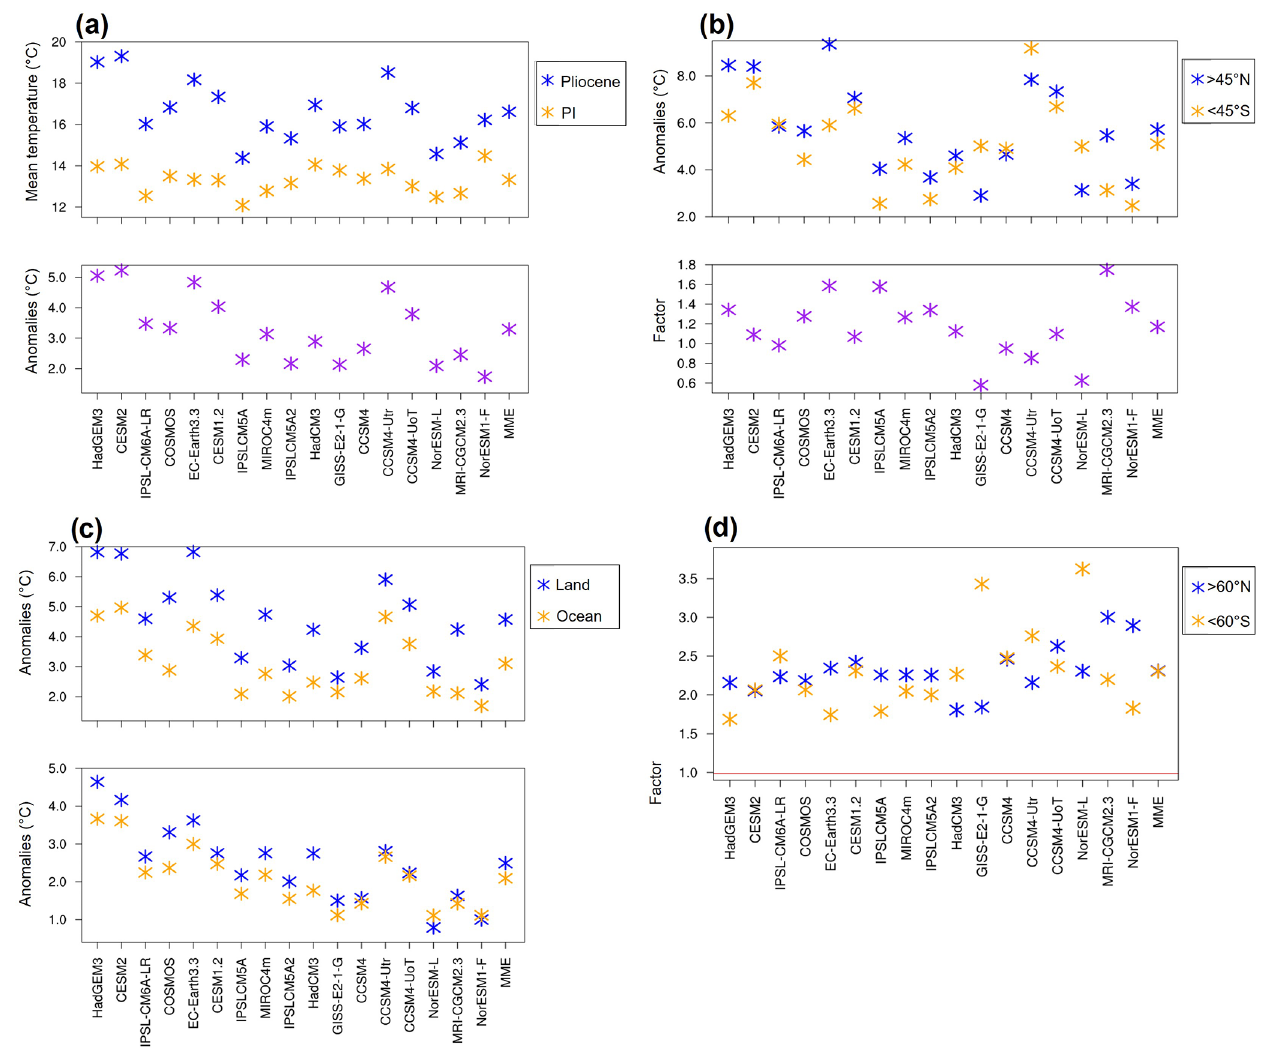
Figure 12. SAT from Pliocene simulations from HadGEM3 and all other models in PlioMIP2: (a) global annual mean SAT (top panel) and anomalies (bottom panel), (b) extratropical ( ± 45 ◦ ) annual mean SAT anomalies (top panel) and ratio (i.e. > 45 ◦ N divided by < 45 ◦ S) between them (bottom panel), (c) land and ocean annual mean SAT anomalies, averaged globally (top panel) and between 20 ◦ N and 20 ◦ S (bottom panel), and (d) annual mean SAT polar amplification, i.e. SAT poleward of 60 ◦ divided by global mean, for each hemisphere, where the red line shows a ratio of 1 (i.e. no polar amplification). Figures reproduced and adapted from Haywood et al.